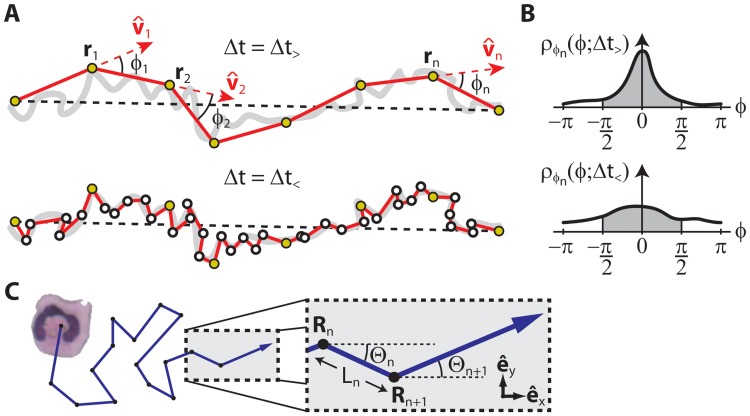
The effects of sampling interval on measurements and characterization of migration trajectories.(A) A migration path sampled with a long sampling interval, Δt = Δt
> (top, outlined yellow circles), and a short sampling interval, Δt = Δt
< (bottom, outlined white circles). Using the long sampling interval diagram, the observed migration path is formed by connecting measurements of centroid positions, r
1, r
2, …, with lines (in red). Unit tangent vectors are shown as v^1,v^2,... while turning angles, ϕ
1, ϕ
2, …, are defined as the angle between successive tangent vectors. Differences in centroid position from the true migration path (thick grey curve) represent measurement error. (B) Turning angle distributions (TAD), ρ
ϕn(ϕ;Δt), based on both the long (top) and short (bottom) sampling intervals. A measure of migration persistence known as TAD persistence is the area under the TAD curve between ±π2 (shaded). TAD persistence depends notably on sampling interval. Similar diagrams can be used to show the sampling interval dependence of metrics such as tortuosity and tangent-tangent correlation. (C) A diagram visually defining terms necessary to analytically derive the directionality time model. A cell is depicted as a random walker with steps (R
1, R
2, …, R
n, …) located in a 2-D coordinate system defined by the unit vectors e^x and e^y. Capital letters correspond to random variables. For each step, there is a corresponding step length L
n and polar angle Θn. The latter is defined with respect to unit vector e^x and should not be confused with the corresponding turning angle, Φn = Θn − Θn−1.